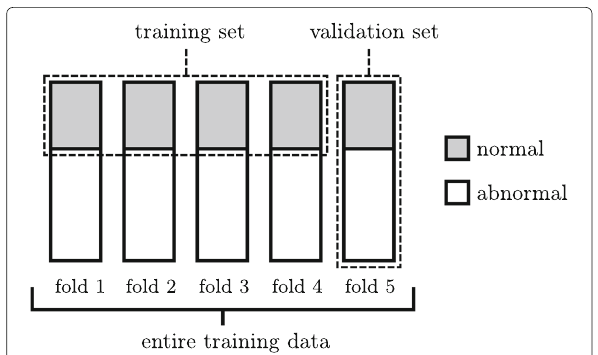
Fig. 6 The formation of training and validation sets for one of 5 models corresponding to a specific network structure in the stage of